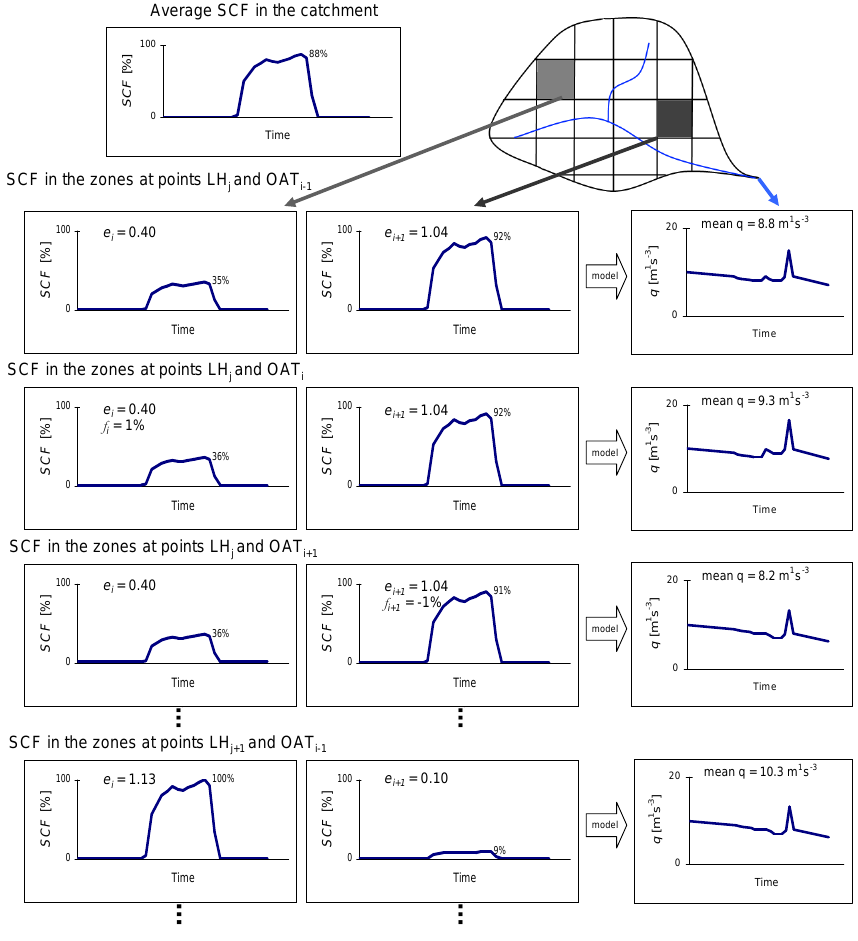
Figure 6. Graph illustrating the spatial LH-OAT SCF sampling for calculating the sensitivity analysis. The top row presents a spatially averaged observed SCF for an example catchment (top left panel) and the example catchment with highlighted snow zones i and i + 1 (top right panel). The next rows present SCF in the zones i (panels in the left column) and i + 1 (panels in the central column) in the advancing LH-OAT loops starting from the loop [ i − 1 ,j ] and the discharge simulated during these loops (panels in the right column). Symbols are the same as in Eq. (4): e i and e i + 1 represent a fraction of the SCF in the snow zones i and i + 1, f is the fraction by which e was changed